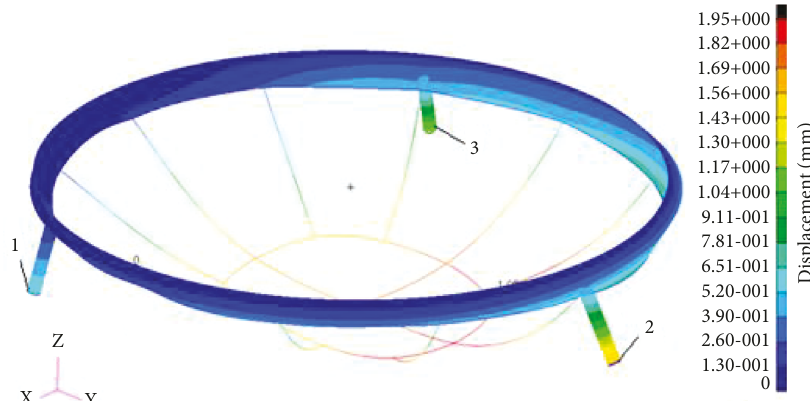
Figure 9: Displacement of the bottom of the re-entry